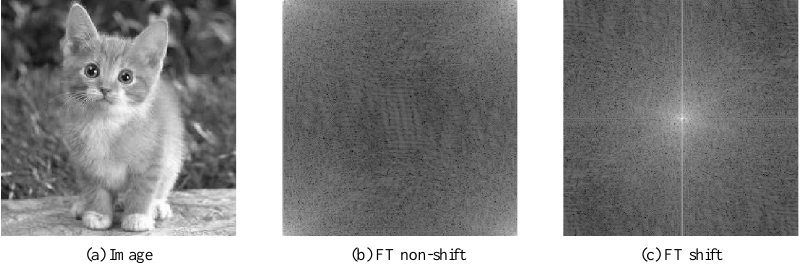
Figure 3. ( a ) Original gray-scale image. ( b ) Our proposed Fourier transformed image without shift operation. ( c ) Traditional Fourier transformed image with shift